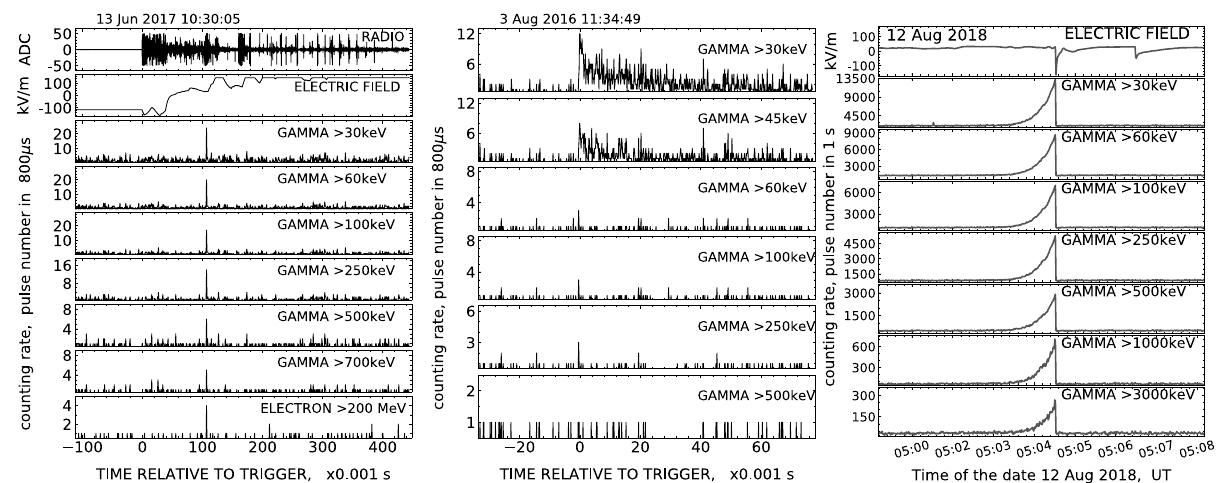
Figure 3. Example of physical results gained at the high altitude detector point. Left: typical imprint of a short electron / gamma avalanche which has occurred at lightning moment. Middle: a transient prolonged flash of the soft gamma-radiation observed in thunderstorm time. Zero point of time axes both in the left and middle panels corresponds to beginning of discharge development. Right: a TGE event observed in time of a close thunderstorm.